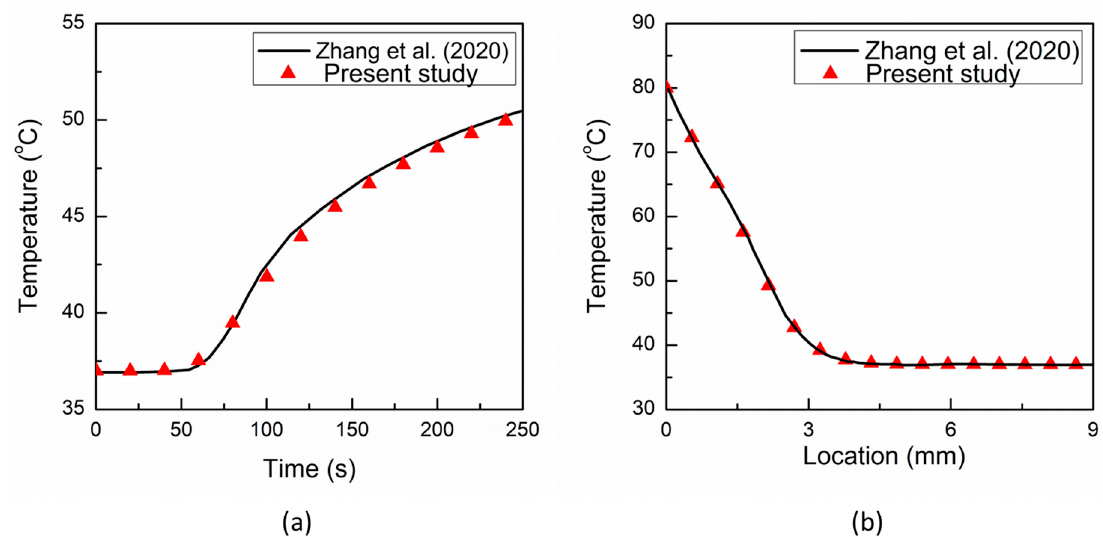
Figure 2. Comparison of the predicted results of the present TPL model with that of Zhang et al. (2020) [33] : ( a ) temporal evolution of temperature at a location of 4.5 mm; and ( b ) temperature distribution at time t = 50 s.